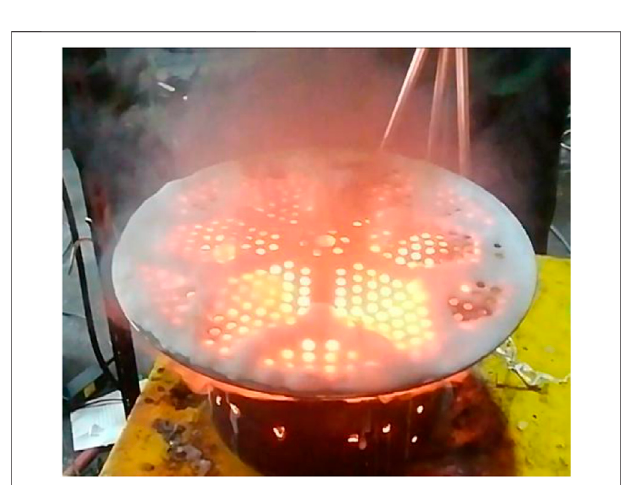
FIGURE 4 | AFFF foam in CO concentration determination experiment.